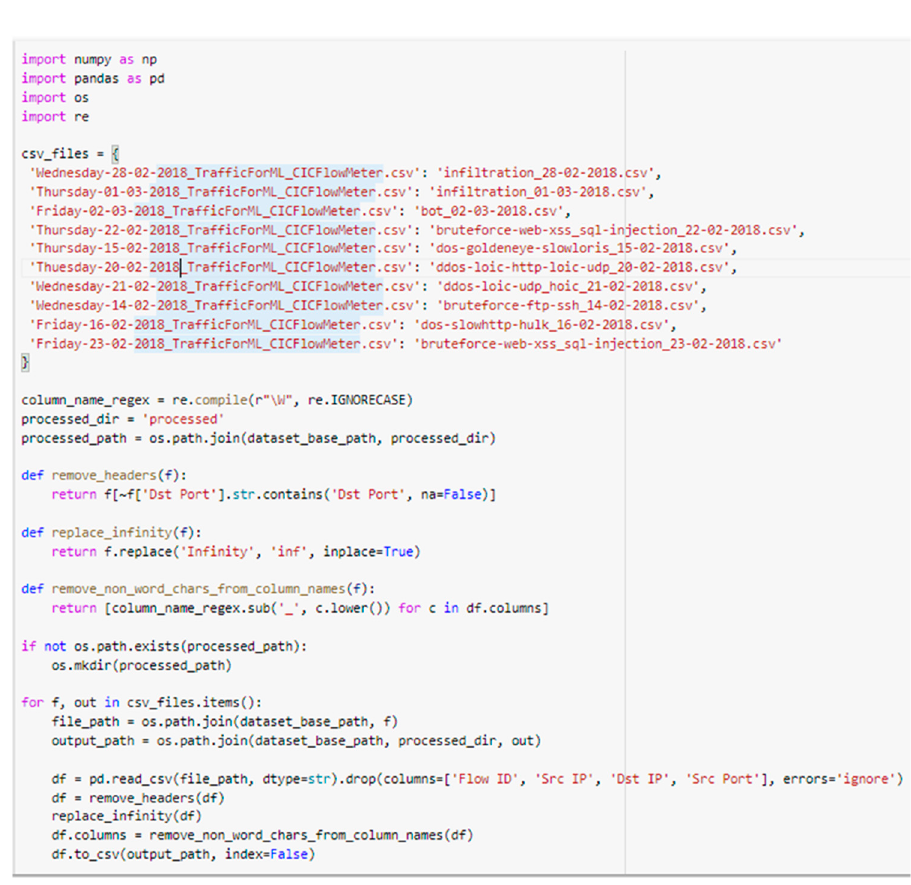
Figure A1. Script for data cleaning.